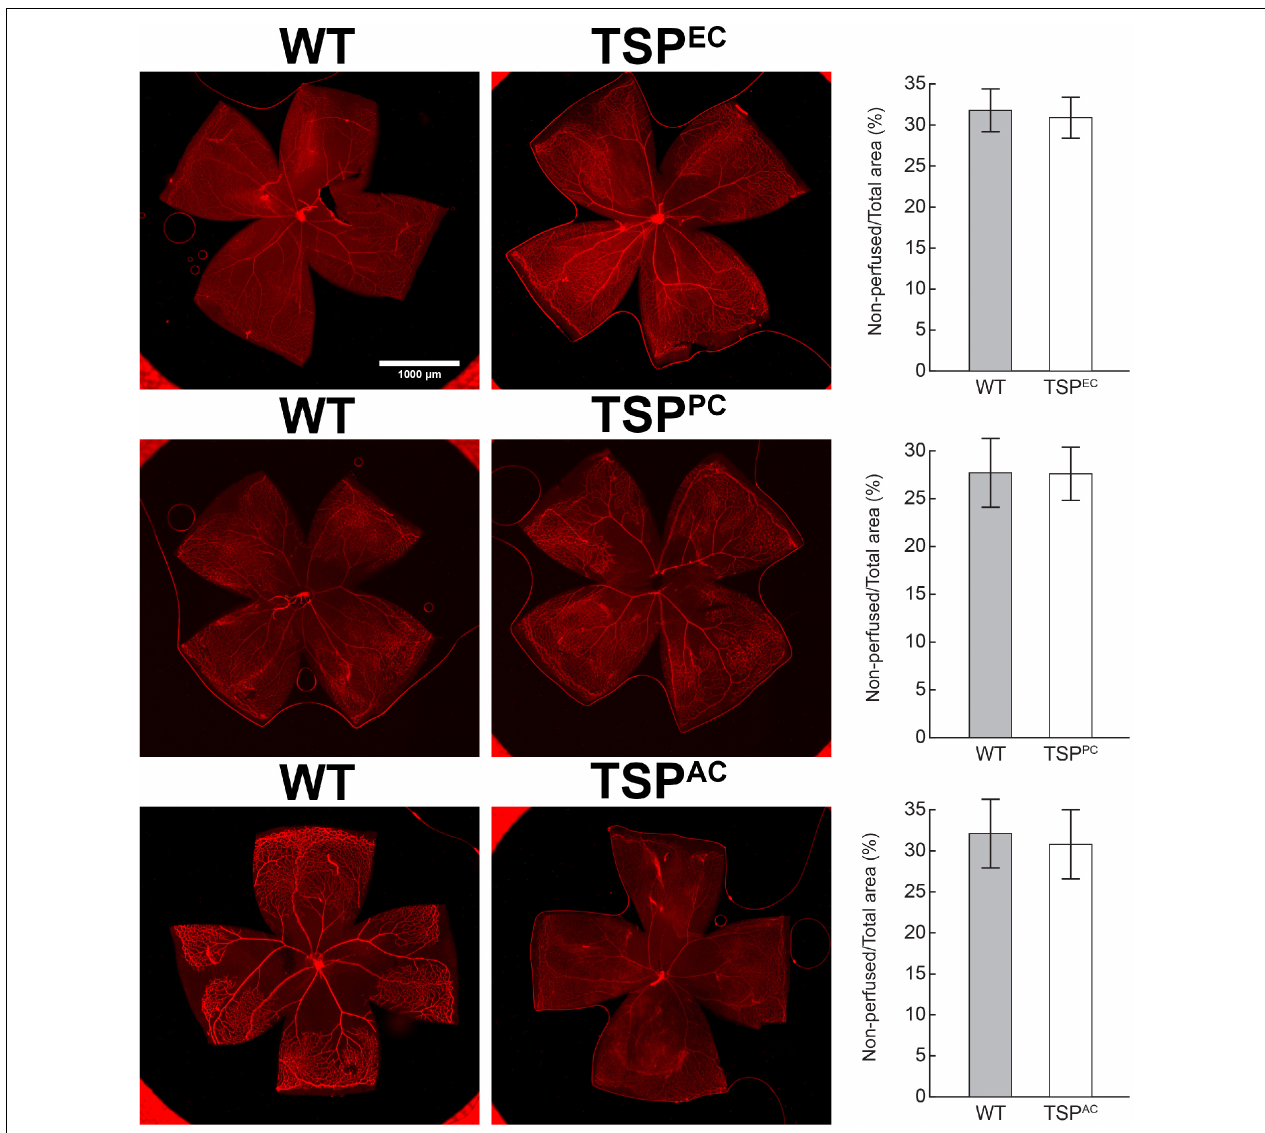
FIGURE 5 | Lack of TSP1 expression in endothelial cells, pericytes or astrocytes did not attenuate hyperoxia-driven vessel obliteration. Vessel obliteration P12 mice exposed to a cycle of hyperoxia beginning at P7 was assessed. Retinas were wholemount stained with anti-collagen IV to visualize the vasculature. The area of vessel obliteration relative to the whole retina was quantitated ( P > 0.05). Scale bar = 1,000 µ m. Experiments were repeated at least three times with 5 mice per group with similar